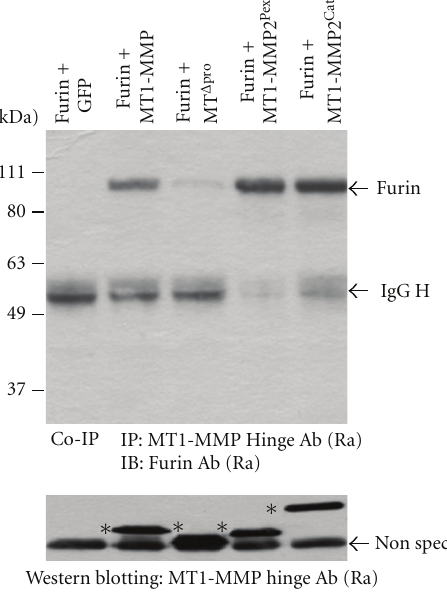
(b) Coimmunoprecipitation assay using Myc antibody: COS-1 cells transfected with furin along with wild type and mutant MMP-28 cDNAs. The cell lysates were immunoprecipitated with anti-Myc monoclonal antibody followed by immunoblotting with furin polyclonal antibody. An aliquot of total cell lysate before immunoprecipitation for α/β tubulin was used as a loading control